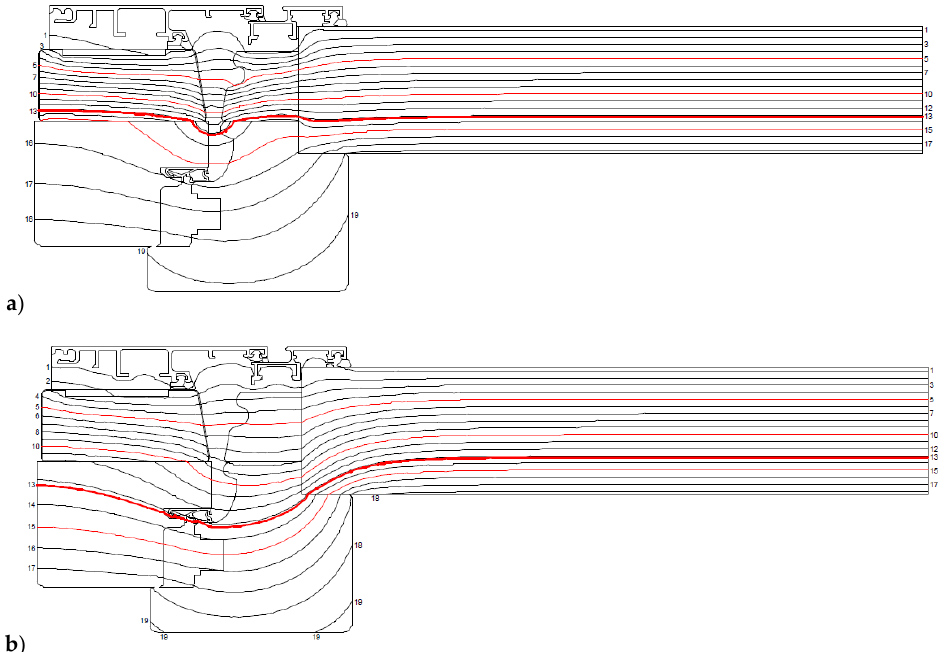
Figure 5. Isothermal lines within the cross section of the newly designed frame with aerogel insulation ( a ) and with expanded polystyrene insulation ( b ). Numbers reported in the figure represent temperatures corresponding to isothermal lines, expressed in °C.